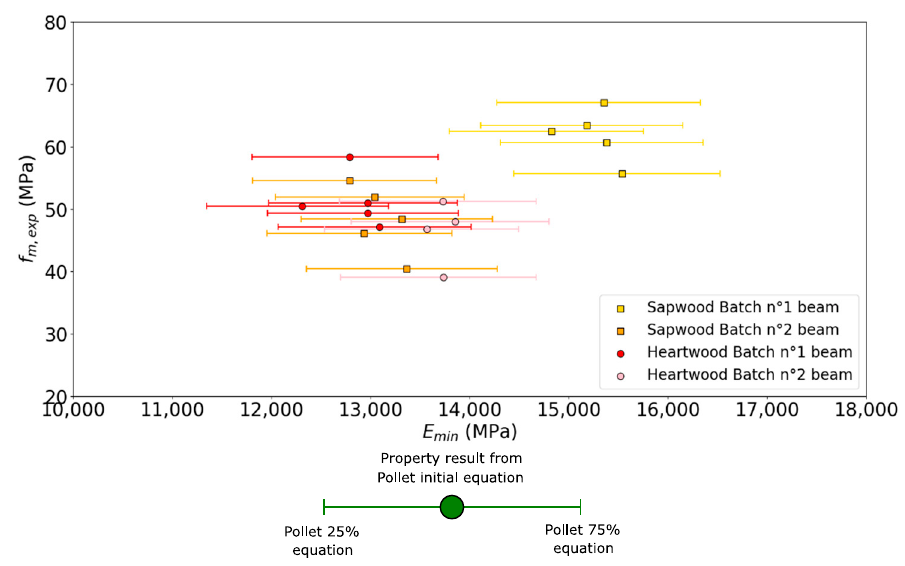
Figure 8. Scatter plot between E mini between loading points from modelization and experimental bending strength.